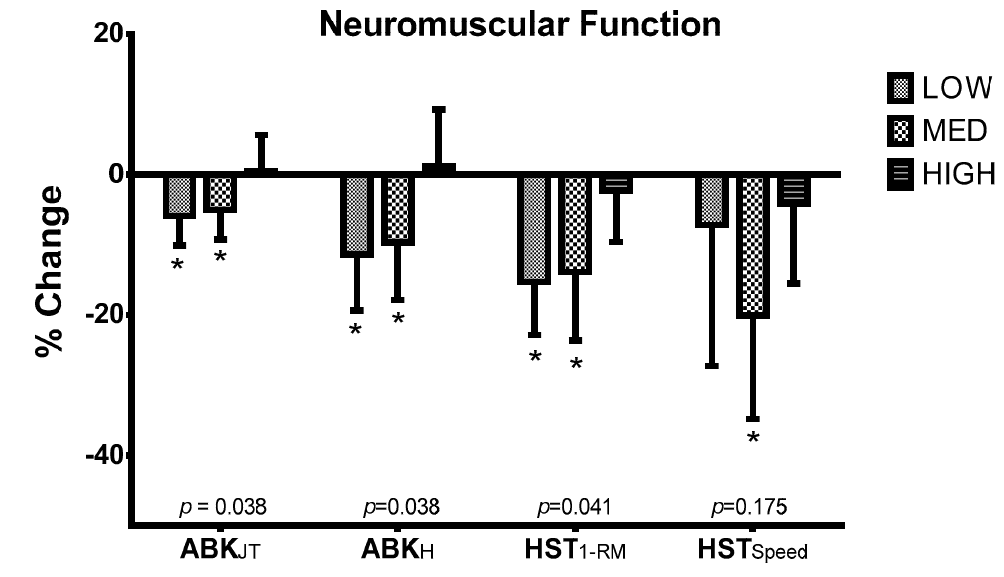
Figure 3. Percentage of changes of neuromuscular function using the Abalakov jump test and half squat test between T1 and T2. * Significant differences compared to HIGH using Mann Whitney u test ( p < 0.05).